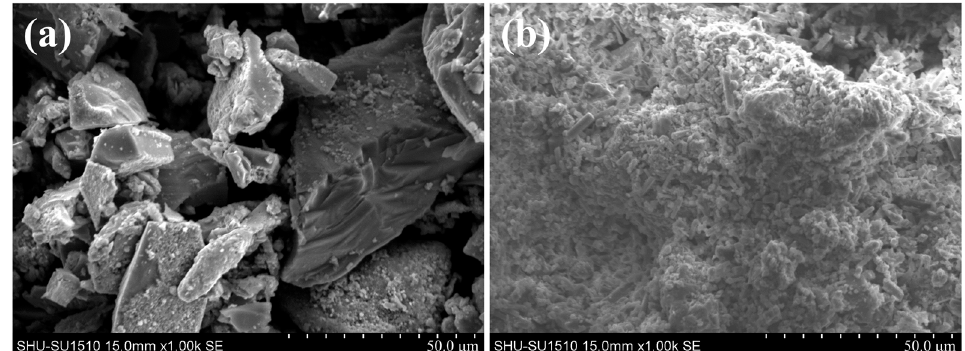
Figure 2. Microstructure of ( a ) Si particles and ( b ) Si 3 N 4 particles.